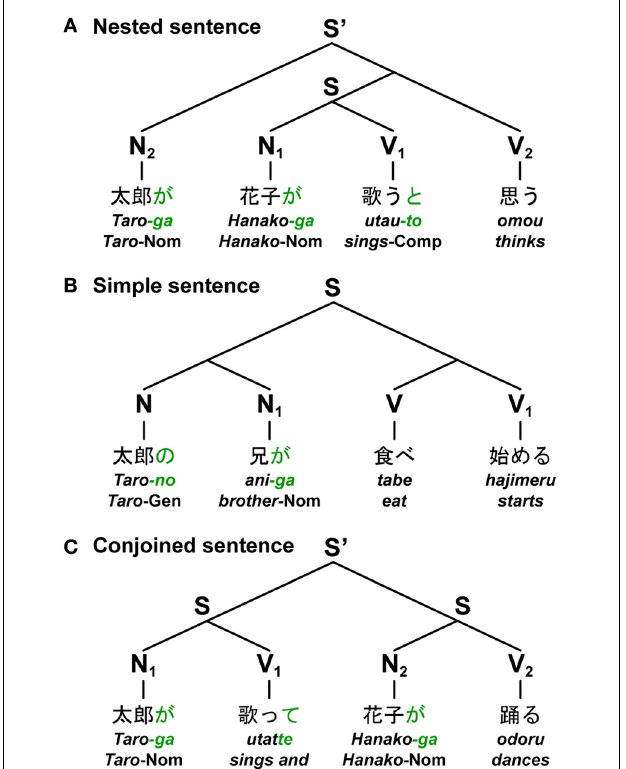
FIGURE 3 | Japanese sentences with three major constructions. The figure shows three basic types of sentences in Japanese: the nested sentence, simple sentence, and conjoined sentence. Based on contemporary linguistics, each diagram represents a unique tree structure of each sentence constructed from nouns and verbs. Below each example, word-by-word translations in English are shown. (A) A sentence (S) at the lowest hierarchical level was nested into an entire sentence (S’) (“ Taro-ga Hanako-ga utau-to omou ,” “ Taro thinks that Hanako sings ”). (B) A simple sentence was constructed by adding the same number of left/right branches to both nouns and verbs (“ Taro-no ani-ga tabe hajimeru ,” “ Taro’s brother starts eating ”). (C) An entire sentence (S’) was constructed by conjoining two sentences (“ Taro-ga utatte Hanako-ga odoru ,” “ Taro sings, and Hanako dances ”). Symbols used: S and S’, sentence; N, noun phrase; V, verb phrase; -ga , nominative case marker; -no , genitive case marker; -to